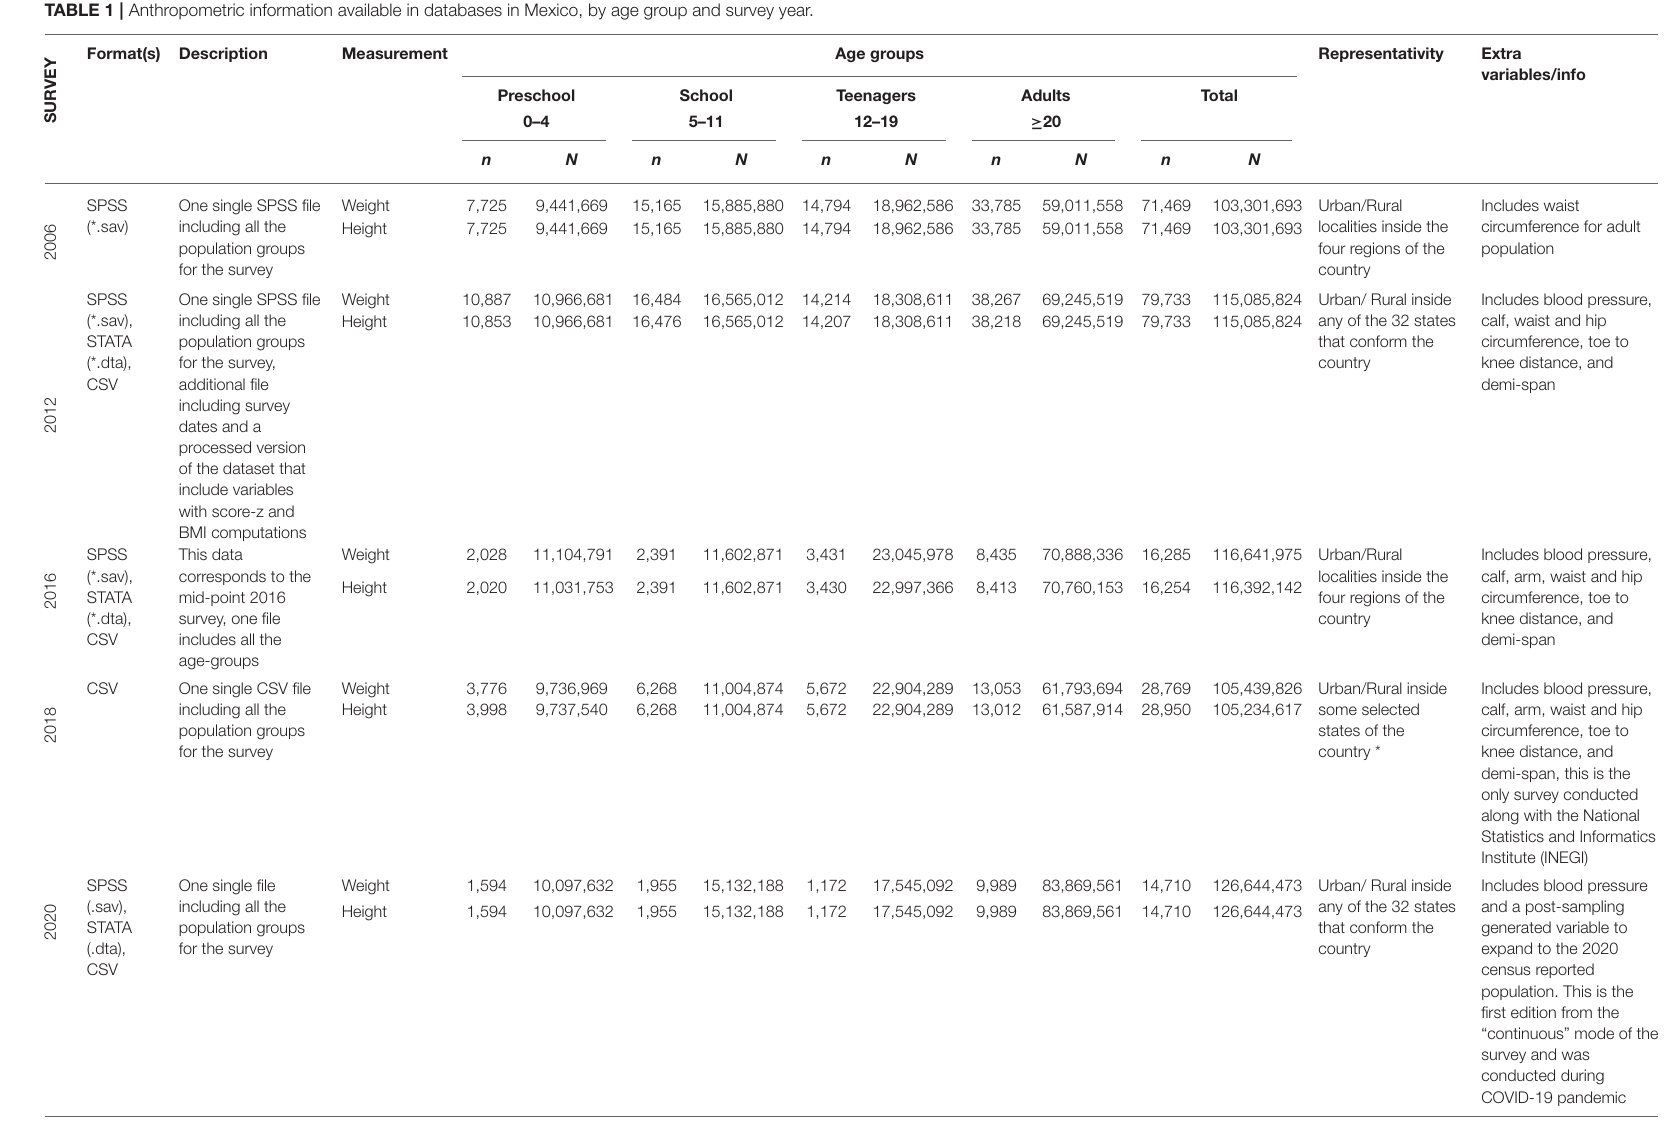
TABLE 1 | Anthropometric information available in databases in Mexico, by age group and survey year.